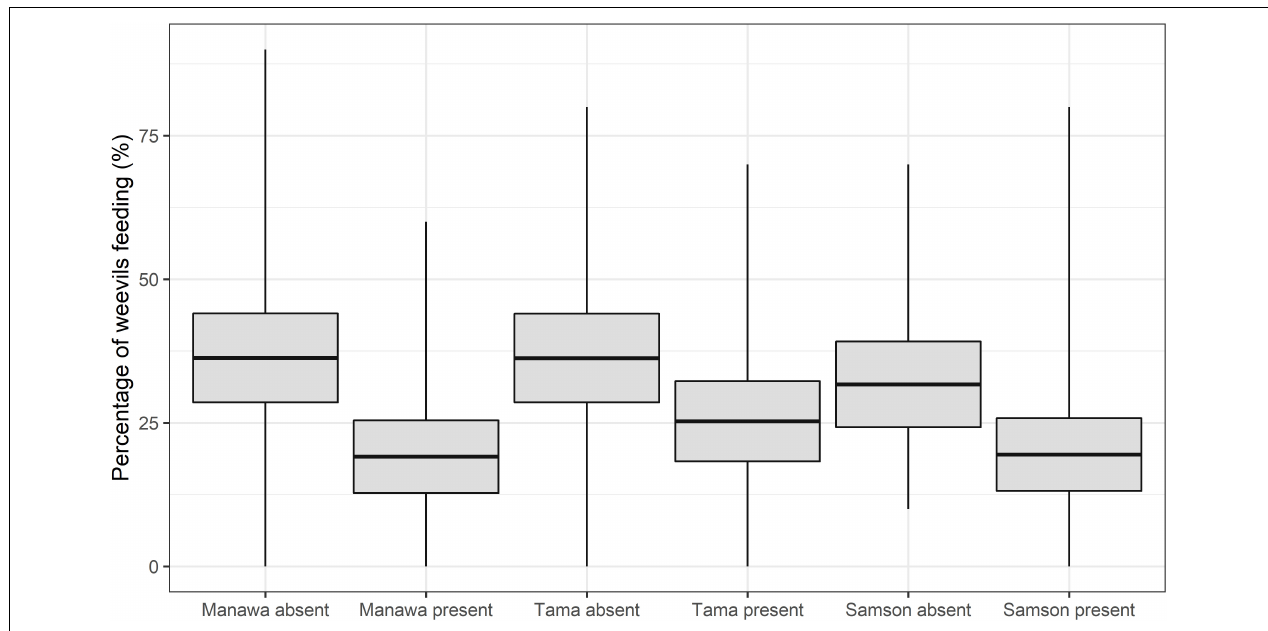
FIGURE 2 | The mean percent feeding of the weevil L. bonariensis in the absence or presence of the parasitoid M. hyperodae on Lolium grasses cv. Manawa, cv. Tama, and cv. Samson. The rectangles show the mean (central line) and 95% CL, and the tails show the range. TABLE 2 | Mean percentages ( ± SEM) of L. bonariensis feeding on three Lolium grass cultivars in the absence (control) or presence of M. hyperodae . Lolium grass cultivars Manawa (Diploid hybrid) Tama (Tetraploid L. multiflorum ) Samson (Diploid L. perenne ) LSD (5%) Microctonus hyperodae treatment Parasitoid Mean percent of L. bonariensis